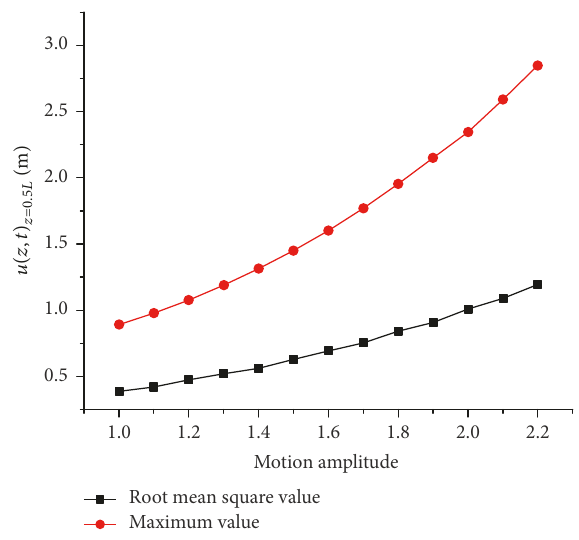
Figure 9: The effect of motion amplitude of top-end tube on the dynamic response of the cable.